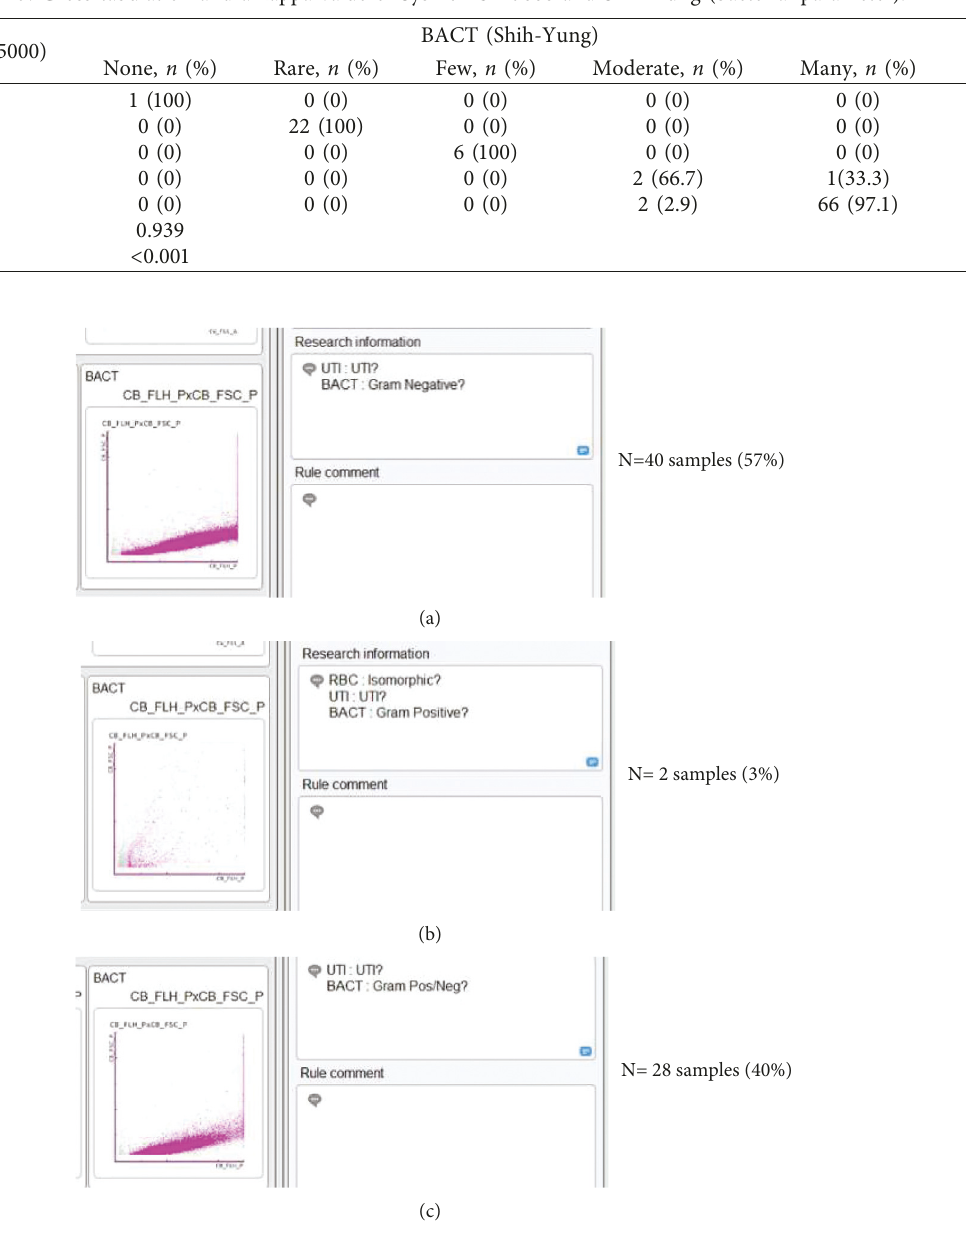
Figure 2: Flagging flow cytometry for bacteria in UTI screening of Gram-negative (a), Gram-positive (b), and mixed Gram-positive and Gram-negative